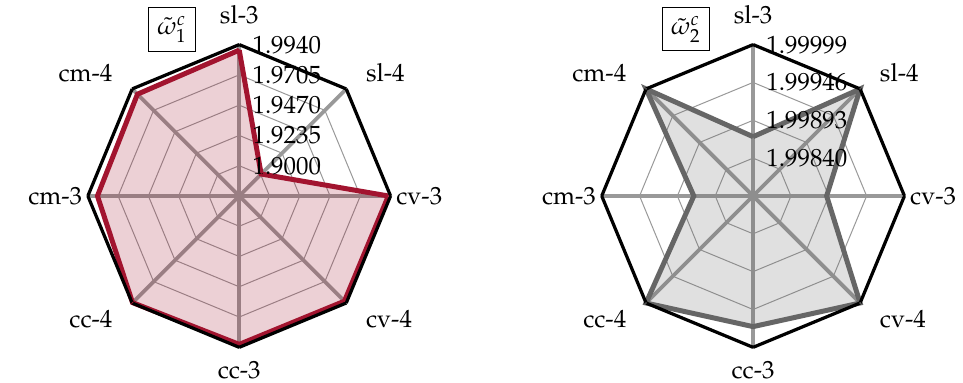
Figure 15. RR/HRR accuracy and stability range comparison for different grid layouts. The recursive-regularization step aims at filtering out non-hydrodynamic modes by ( 1 ) explicit reconstruction of f